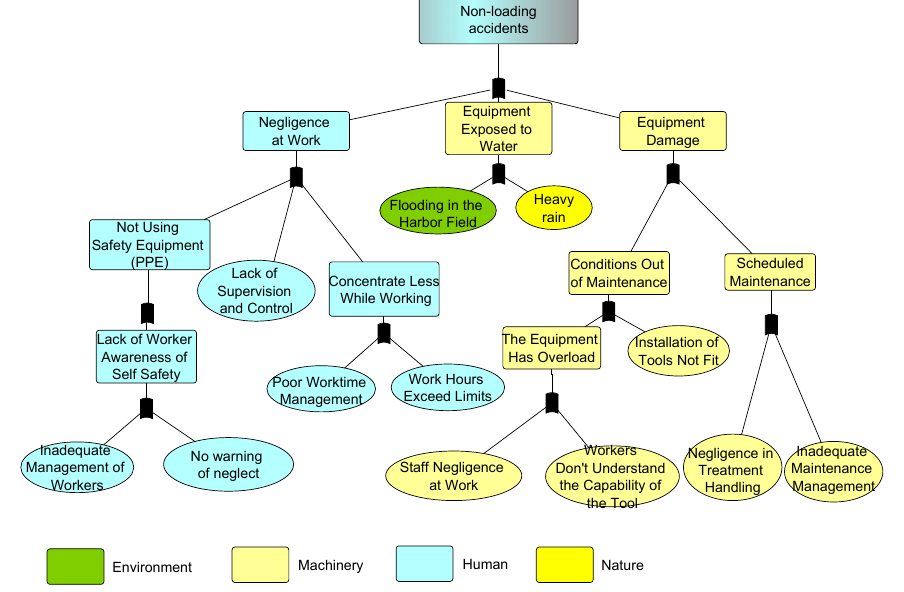
Figure 4. FTA of Non-Loading and Unloading Accidents.